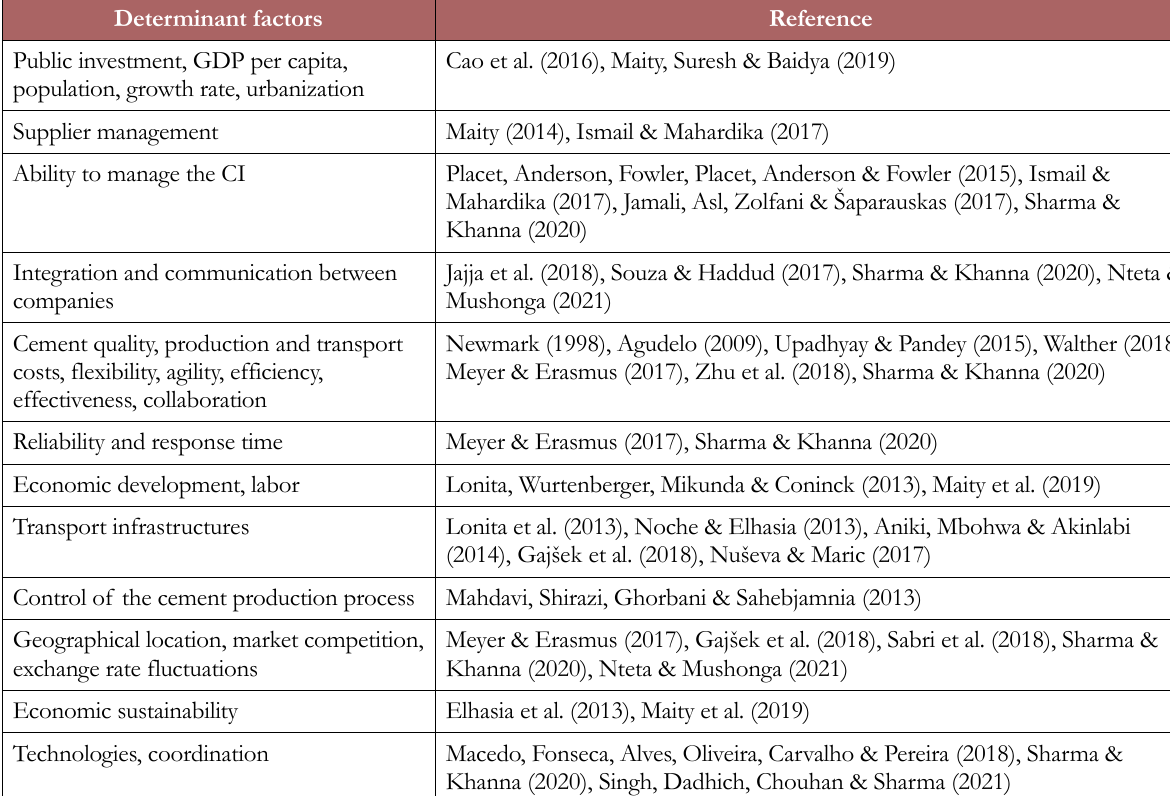
Table 2. Determinants of the cement industry supply